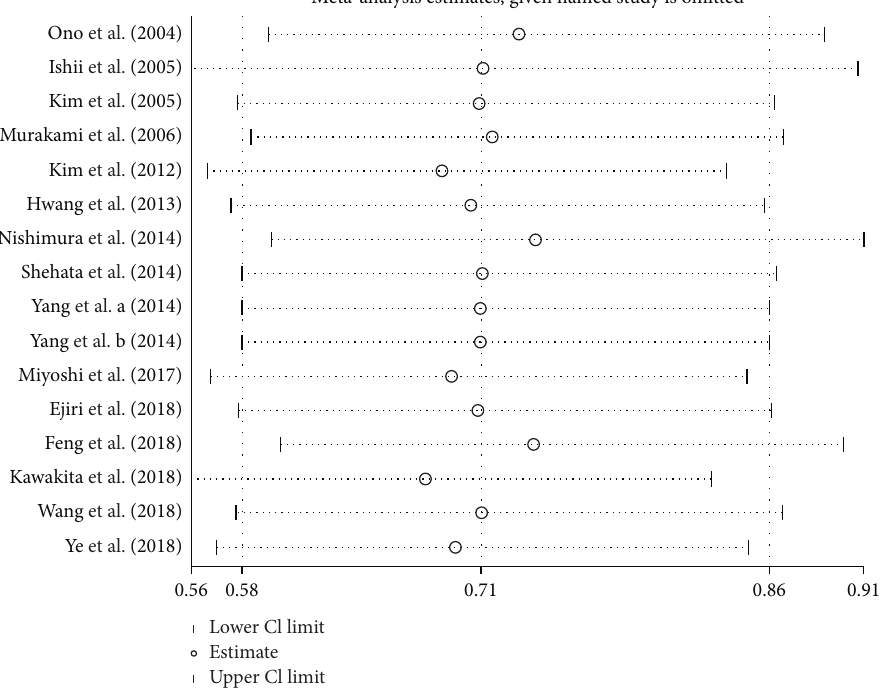
Figure 11: Comparison of MACE between the experimental group and the control group (sensitivity analysis). RR � risk ratio; MACE � major adverse cardiovascular